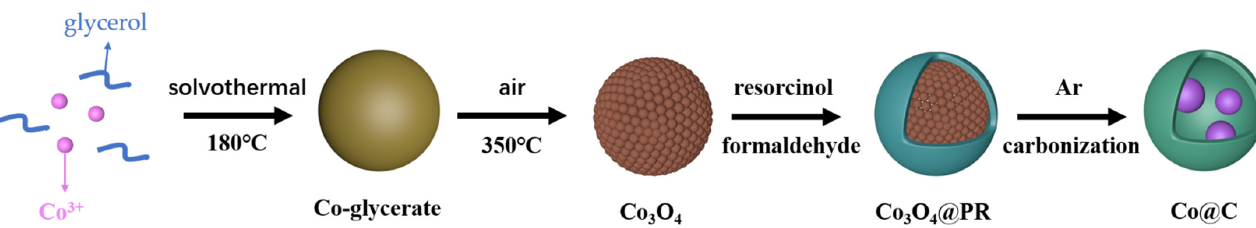
Figure 1. Schematic illustration of the synthetic strategy for multi-core yolk–shell Co@C nanospheres.